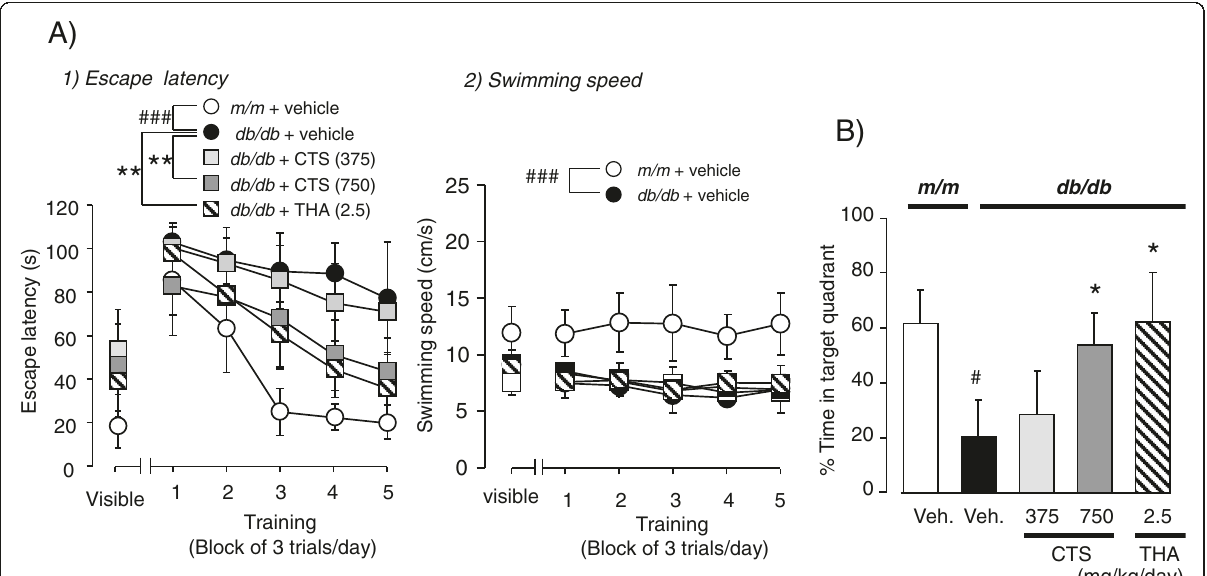
Figure 4 Effects of CTS and THA on water maze performance of db/db mice. Learning performance of the animals was analyzed in the training test by latency ( A ) and swimming speed ( B ). Each data point indicates the mean ± S.D. for 6 – 9 animals in each group. ### P < 0.001 vs. vehicle-treated m/m group, and ** P < 0.01 vs. vehicle-treated db/db group (one-way repeated measures ANOVA). Memory retrieval performance (D) elucidated in the probe test. Each datum represents the mean of time spent in the target quadrant ± S.D. ### P < 0.001 vs. vehicle-treated m/m group ( t -test). * P < 0.05 vs. respective vehicle-treated db/db group (one-way repeated measure ANOVA followed by Tukey